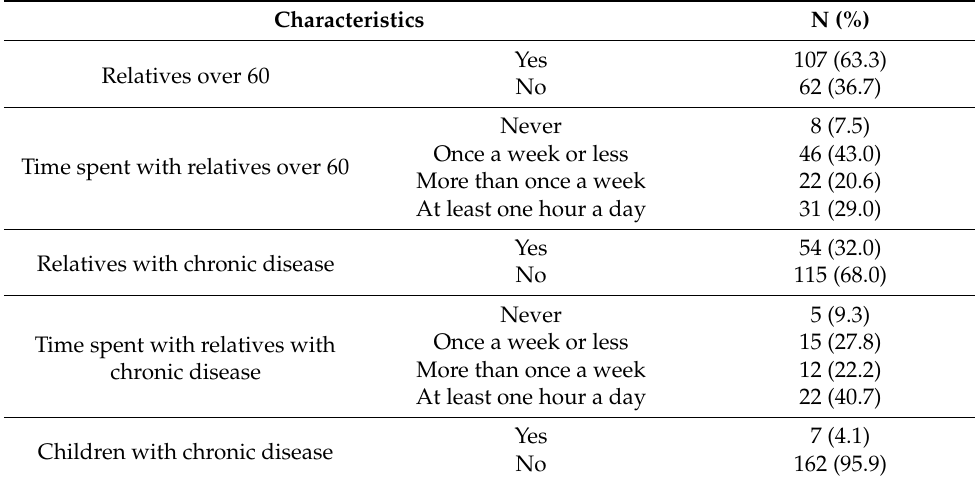
Table 2. Fragilities in children and